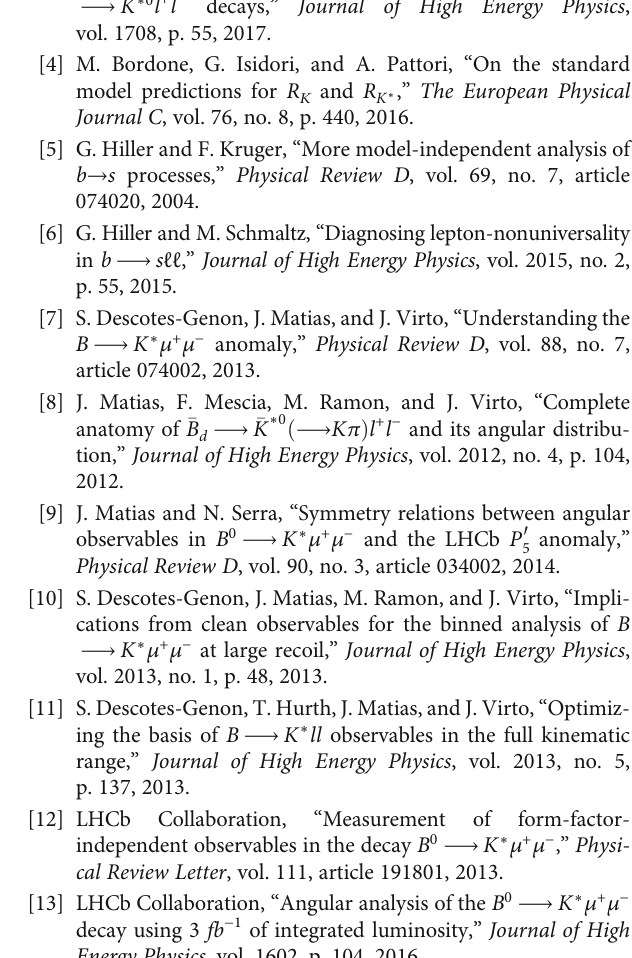
Table 12: Theoretical predictions for the q 2 -binned optimized observables P ′ PQCD (the fi rst low) and “ PQCD+Lattice ” (the second row) approach. q 2 bin GeV 2